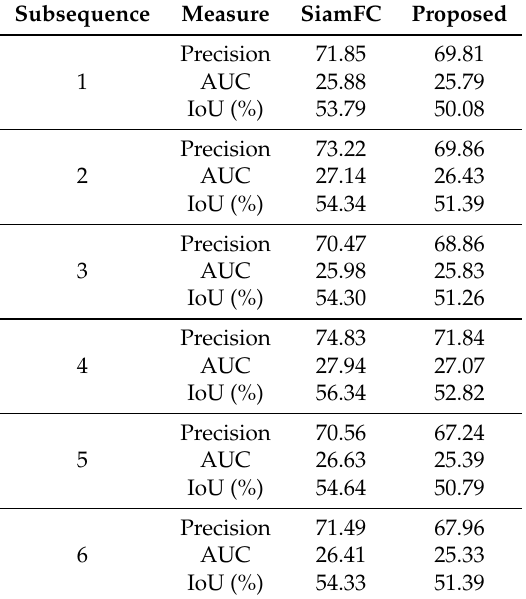
Table 1. The precision, area under curve (AUC), and intersection over union (IoU) of VOT2014.